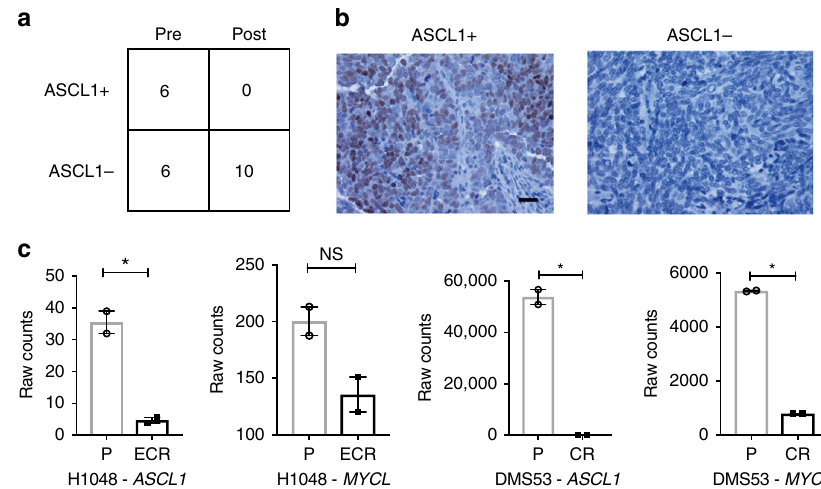
Fig. 3 ASCL1 and MYCL are downregulated in post-chemotherapy human SCLC tissue and chemotherapy resistant cell lines. a Contingency table with number of chemotherapy naive (pre) and post-chemotherapy (post) SCLC human samples stained with antibodies to ASCL1. b Representative IHC for ASCL1 positive staining (brown) and negative staining (blue). Scale bar represents 20 μ m. c RNA expression (counts) for indicated genes (ASCL1, MYCL) from matched pairs of chemotherapy-naive and resistant human SCLC cell lines performed in biological duplicate and compared using unpaired t- tests. H1048 NCI-H1048, P parental cells, CR cisplatin resistant, ECR etoposide and cisplatin resistant, * p < 0.05, NS not signi fi cant. Error bars are mean